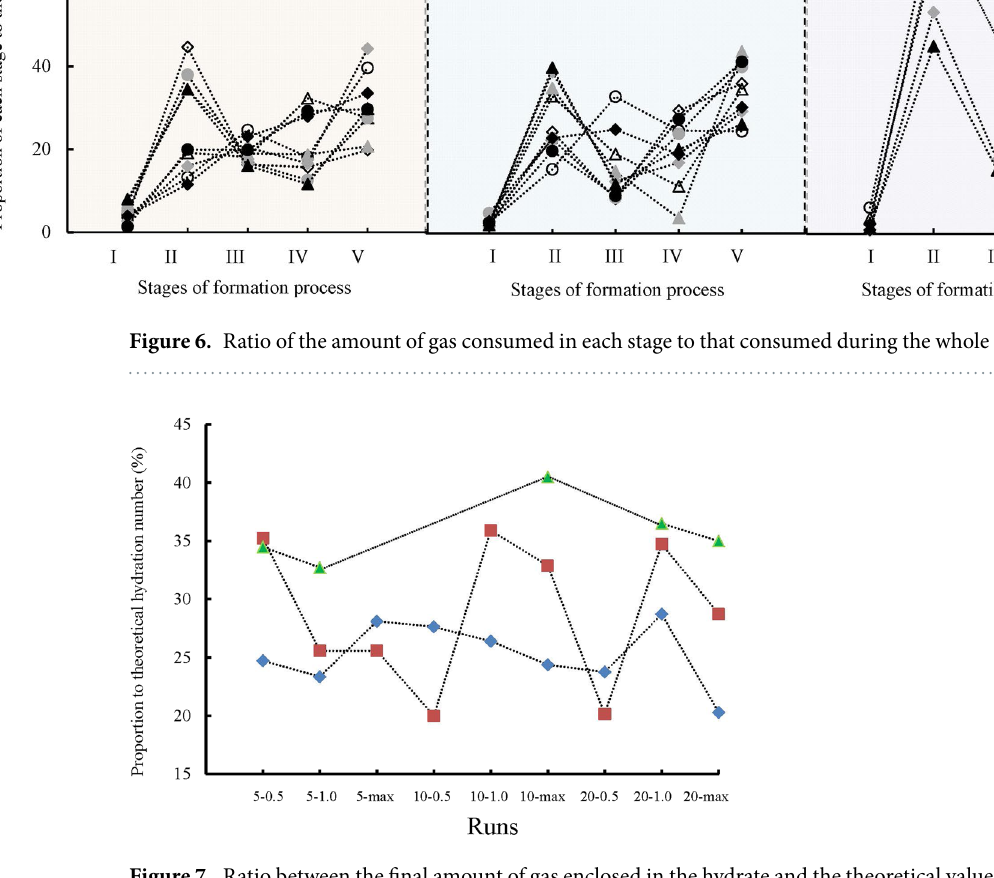
Figure 7. Ratio between the final amount of gas enclosed in the hydrate and the theoretical value for each experiment. The diamond, square, and triangle markers represent the experiments conducted at 1.45, 6.49, and 12.91 °C,